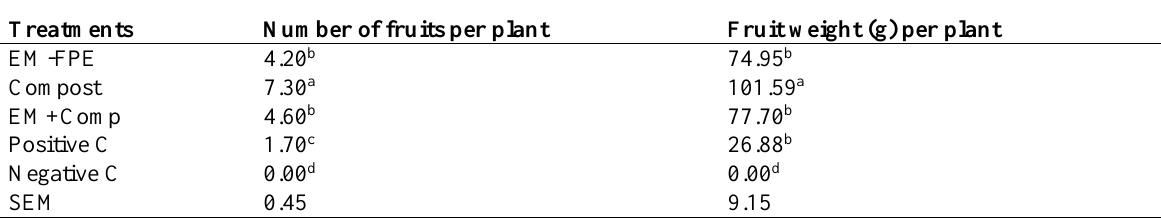
Table 6 Effect of treatment on the number of fruits and the fruit weight of tomato plants infected with Meloidogyne incognita under screenhouse conditions